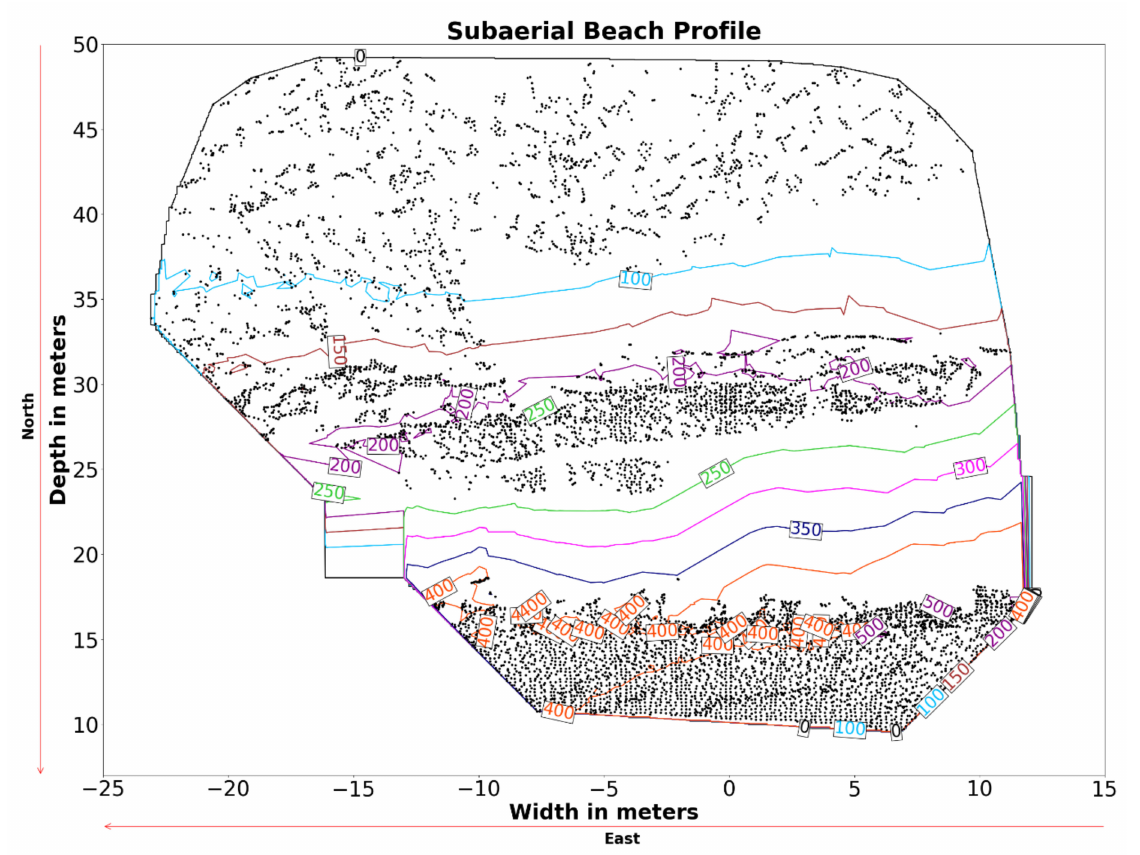
Figure 7. Subaerial Beach Profile; where x-axis represents the width and y-axis represents the depth concern to sensing station. The elevation data are also shown on the contour